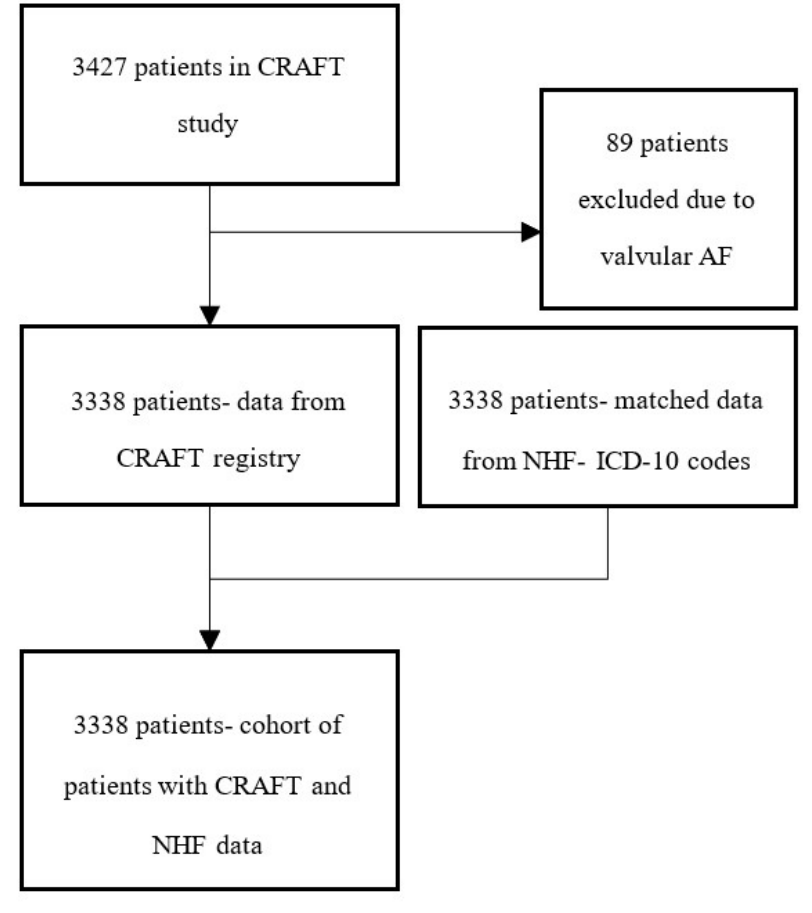
Figure 1. Patient-flow diagram in the study. Table 1. Comparison between IHR and NHF data. IHR data is treated as